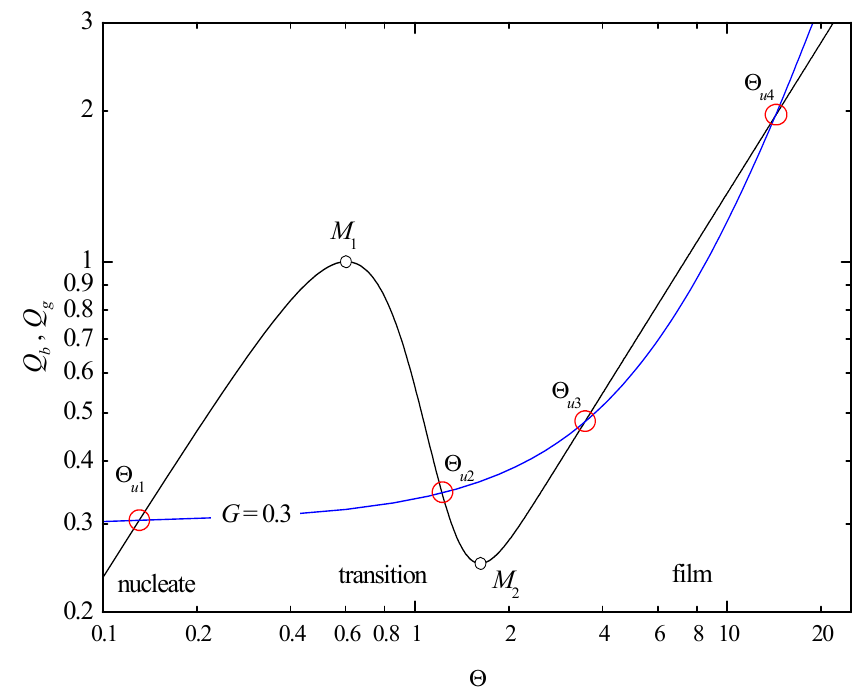
Figure 9. Example of four solutions of ∆ Q = Q c ( Θ ) − G ρ ( Θ ) = 0 .